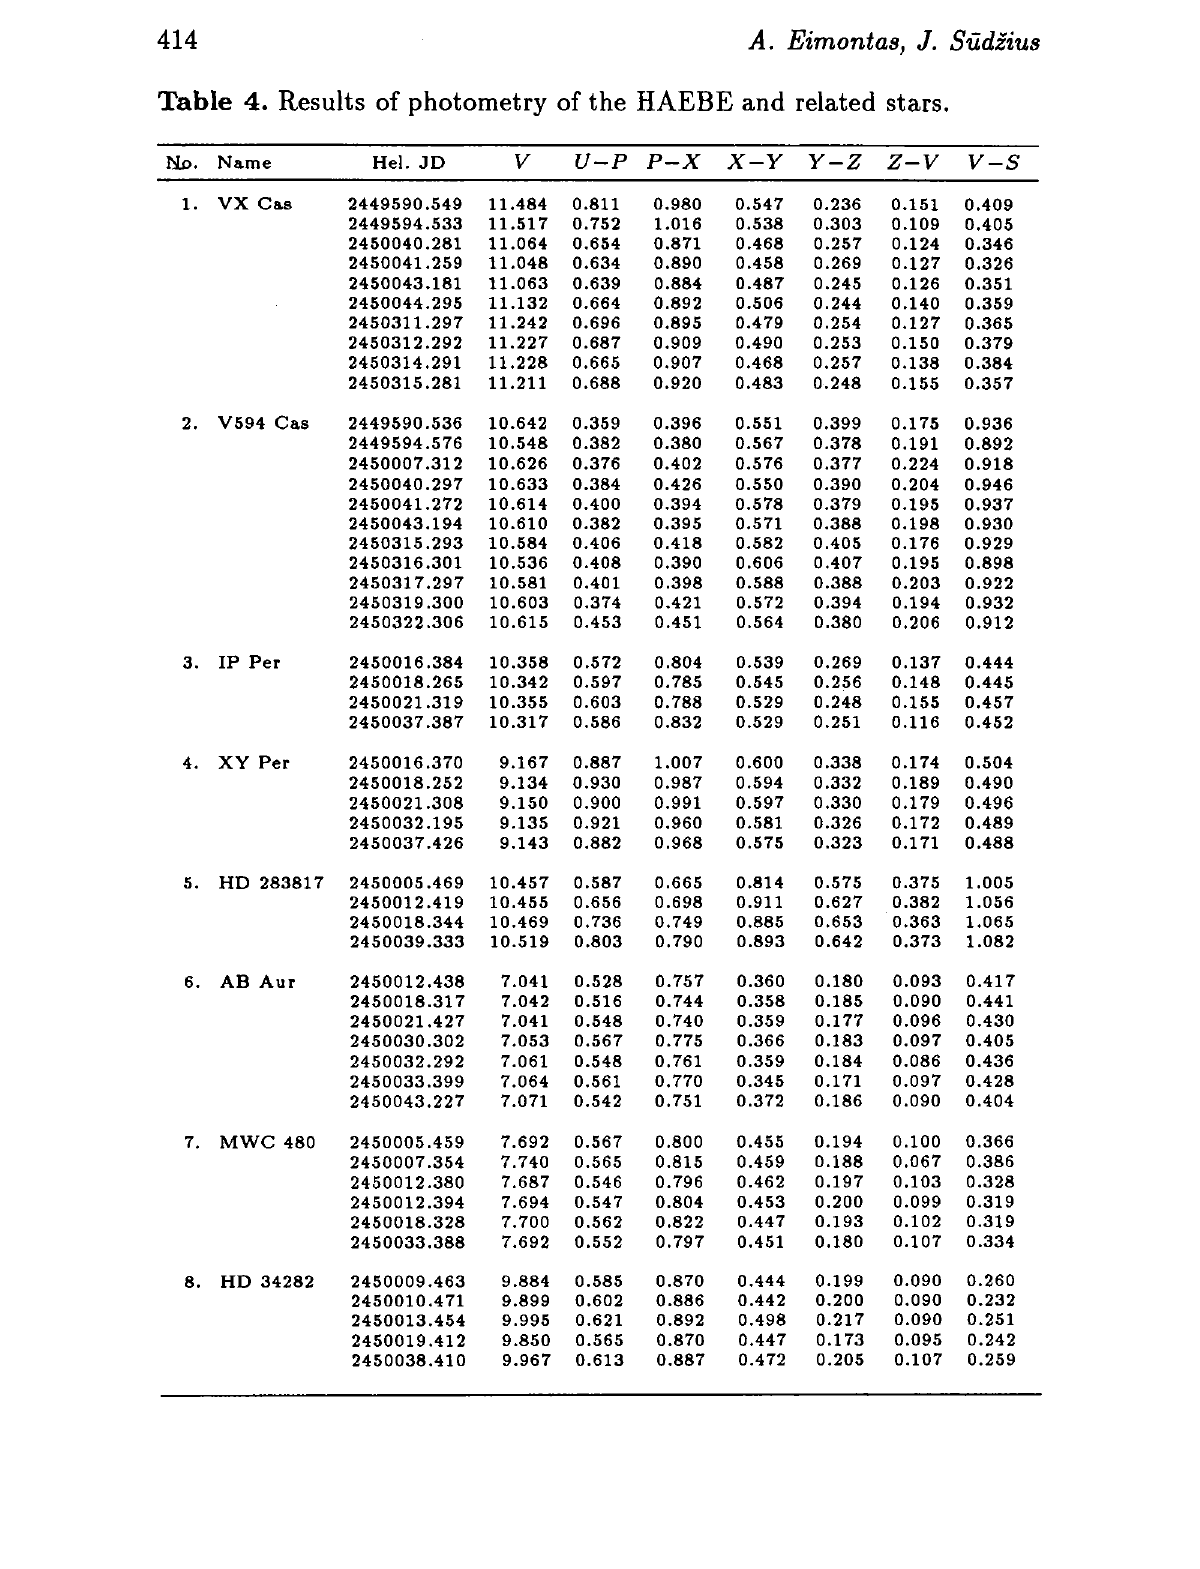
Table 4. Results of photometry of the HAEBE and related